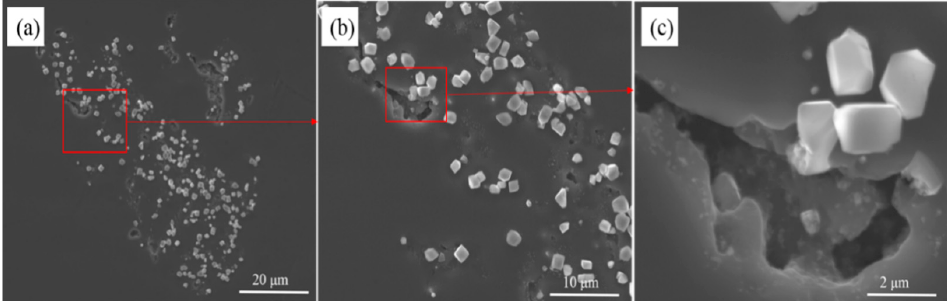
Figure 3. ( a ) The micro-morphology of 1235 alloy foil after being held in the commercial pure aluminum melt for 30 min; ( b ) High magnification view of the area denoted by red frame in ( a ); ( c ) High magnification view of the area denoted by red frame in ( b ).